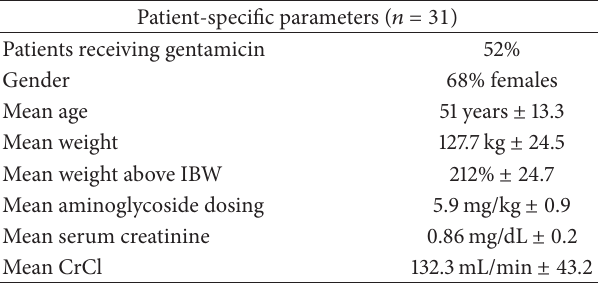
Table 1: Patient demographics.